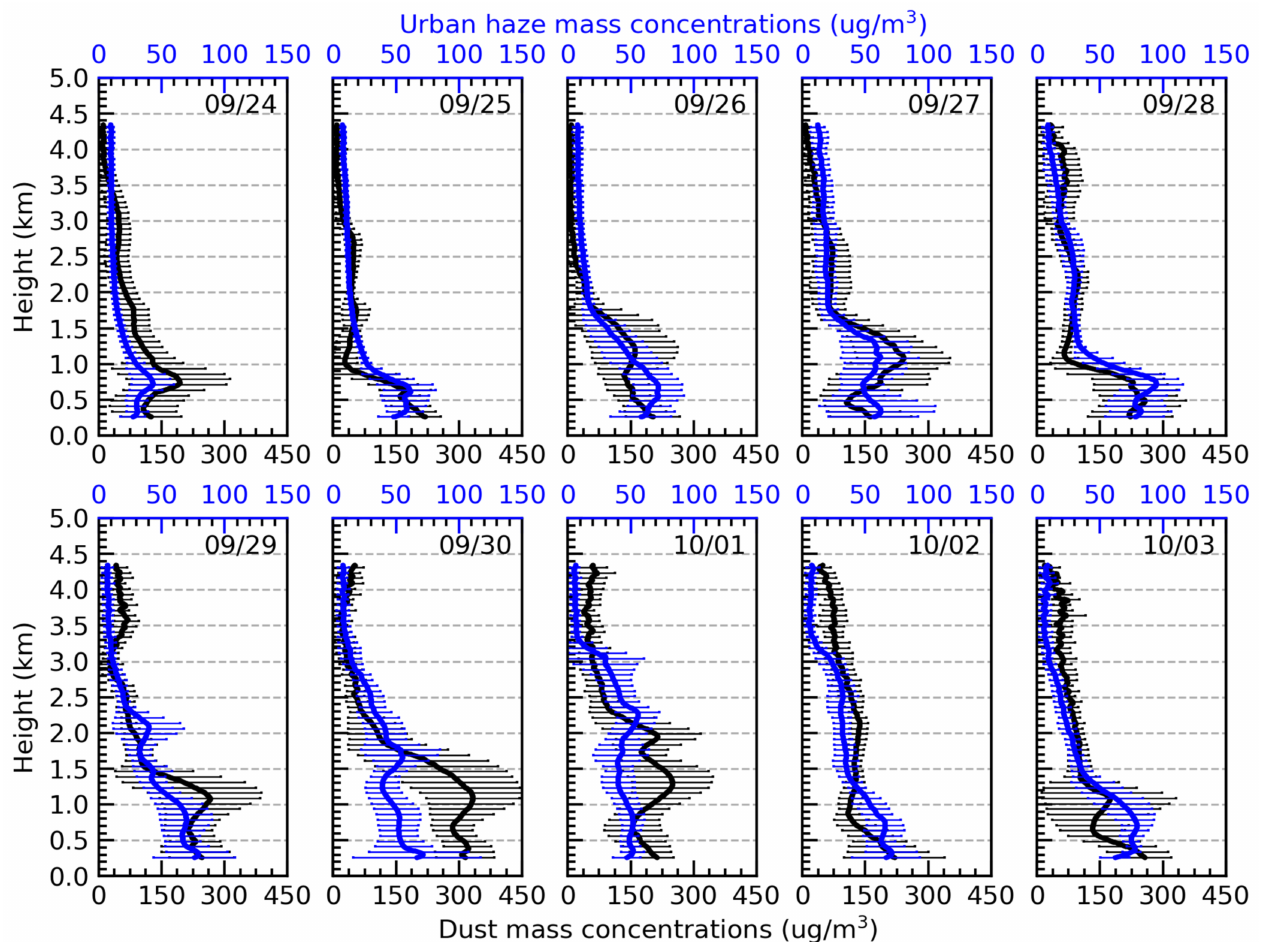
Figure 6. Height profiles of the daily average dust mass concentrations ( black ) and urban haze mass concentrations ( blue ). The envelopes in dust and urban haze mass concentrations represent the one standard deviation at each height. The date is displayed at the top right of each